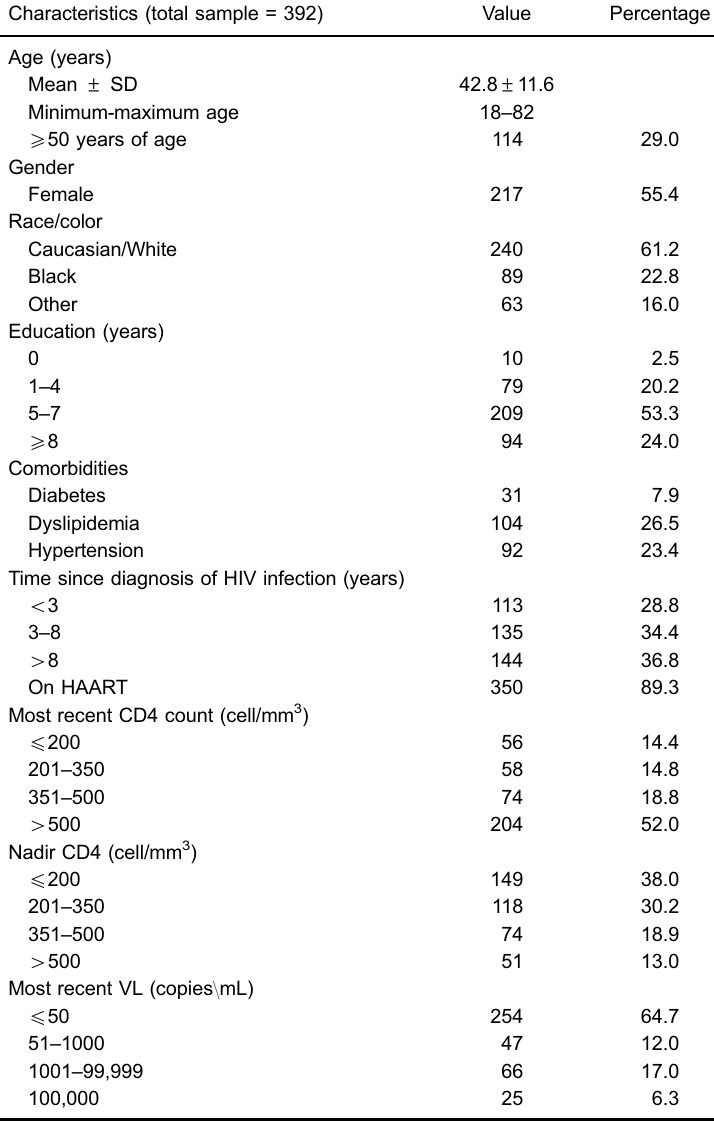
Table 1. Clinical and epidemiological characteristics of the